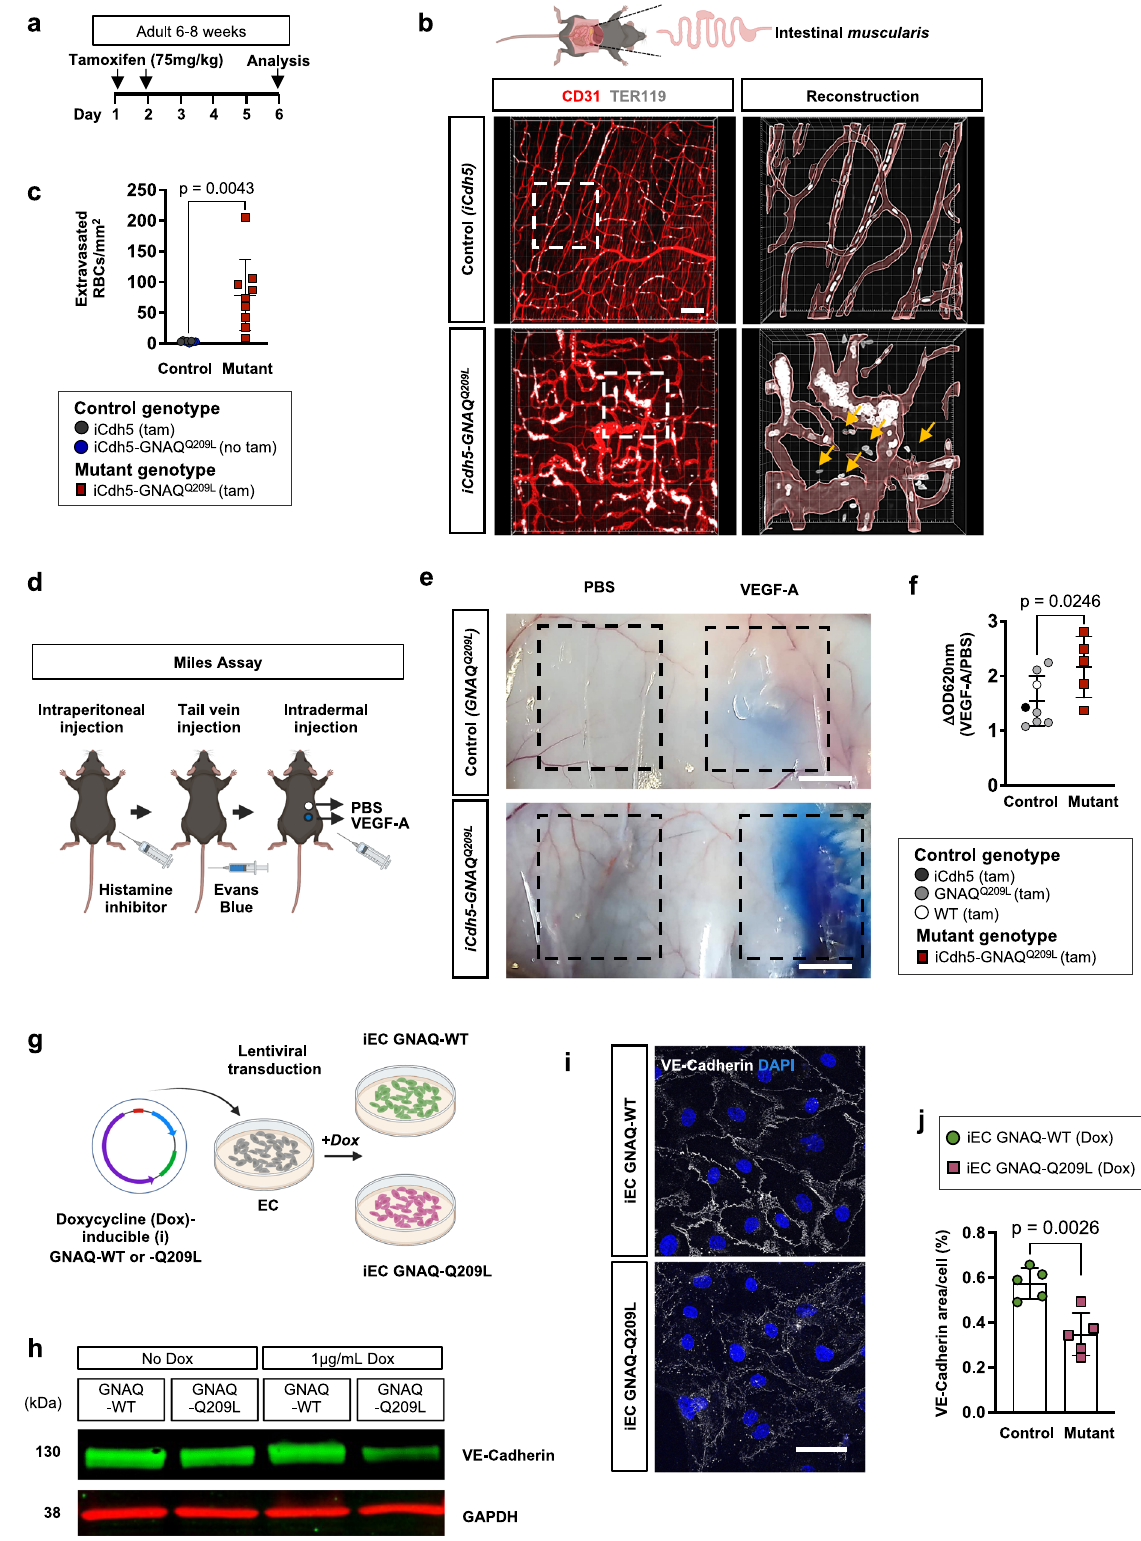
area showed that it was increased in the lesional patient tissue compared tonormalforeskin (Fig. 6f, g).Furthermore,the numberof pERK + ECs, Ki67 + ECs and double-positive (pERK + /Ki67 + ) ECs were higher in the patient tissue compared to control human foreskin from 5 different donors (Fig.